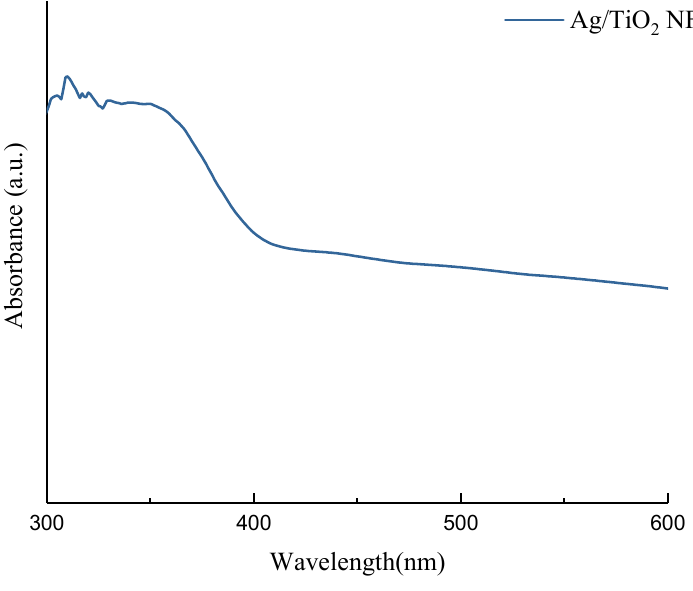
Figure 4. The UV–vis absorption spectra of Ag/TiO 2 NF.